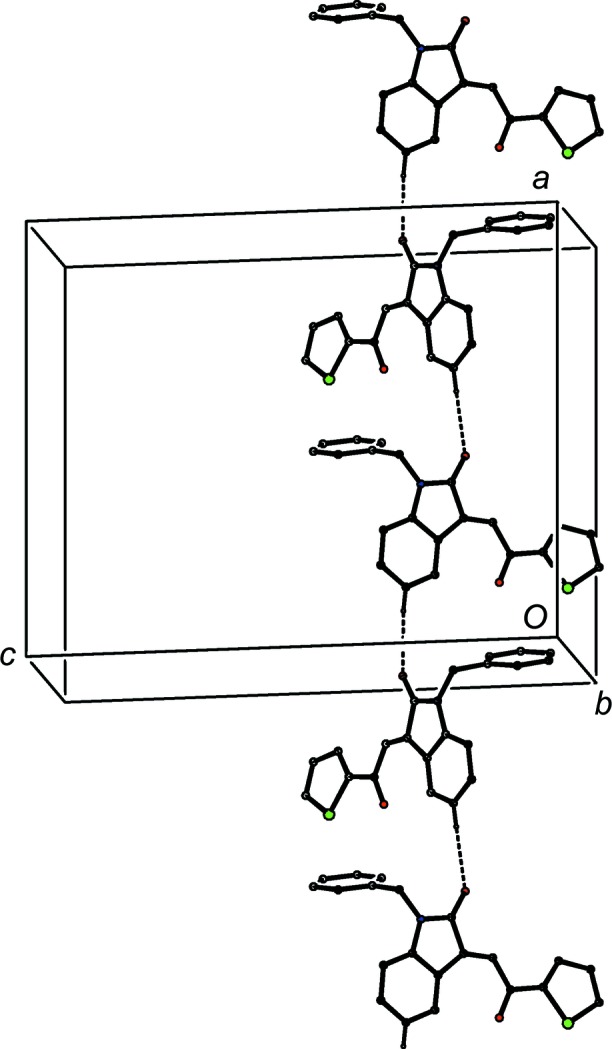
Part of the crystal structure of com­pound (IIg), showing the formation of a hydrogen-bonded chain running parallel to [100]. Hydrogen bonds are drawn as dashed lines and, for the sake of clarity, the minor-disorder com­ponent and H atoms not involved in the motif shown have been omitted.